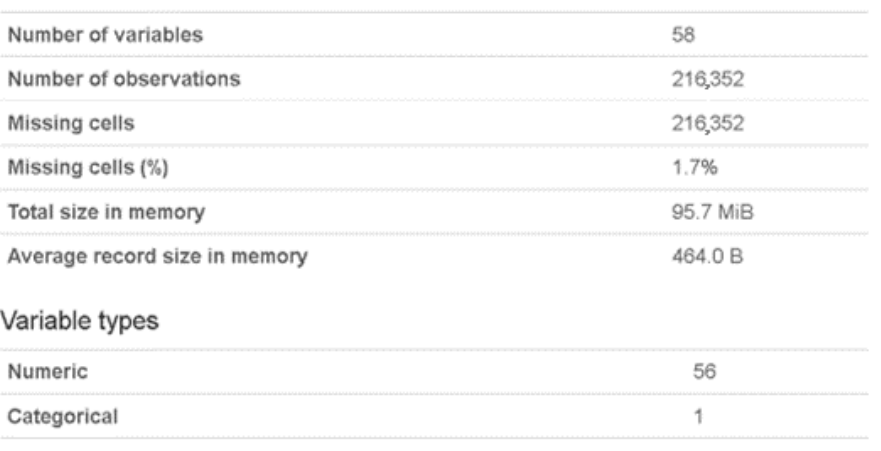
Figure 1. Initial dataset statistics.